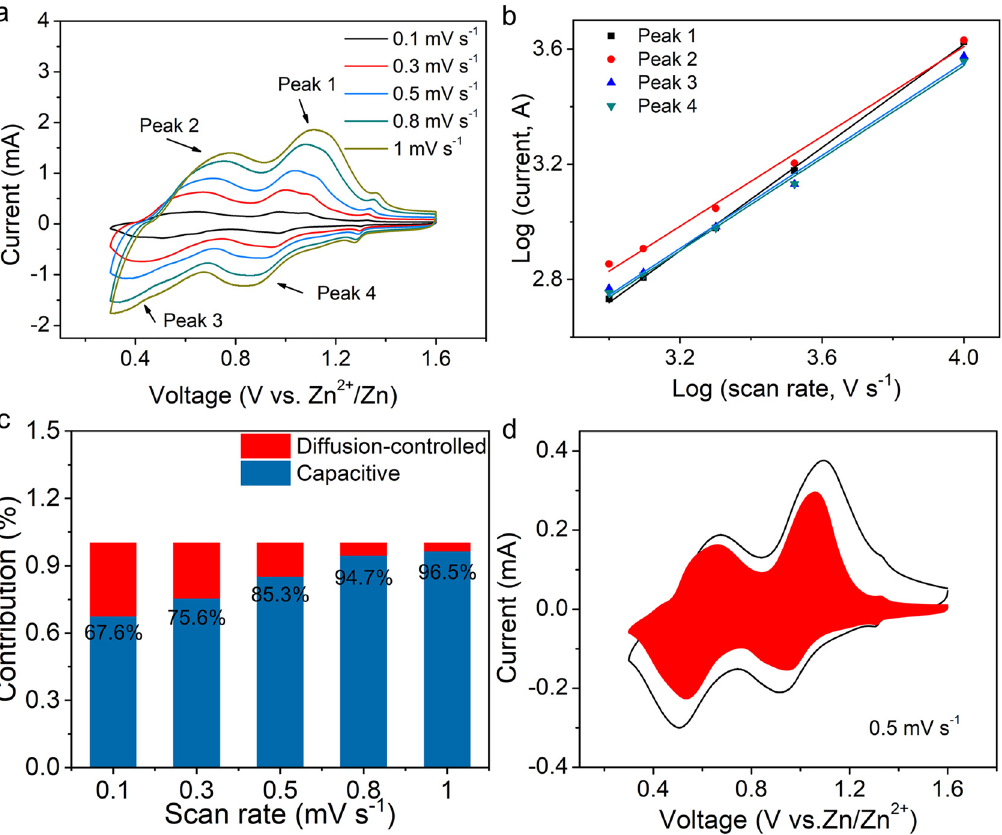
Figure 5: ( a ) The CV curves at di ff erent speeds of CVO - 2. ( b ) log ( i ) vs log ( v ) plots in CV curves. ( c ) Contribution ratio at di ff erent scanning speeds. ( d ) Capacitive contribution at 0.5 mV s − 1